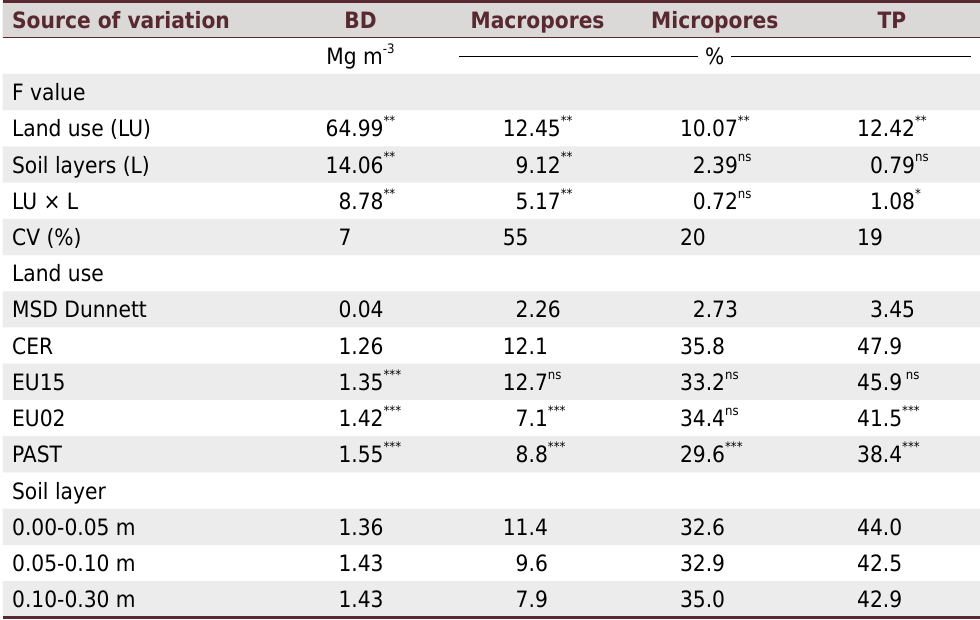
Table 2. Bulk density (BD), macro- and micropores, total porosity (TP), F values and coefficient of variation (CV) for land uses (preserved Cerrado - CER, 15-year-old Eucalyptus - EU15, 2